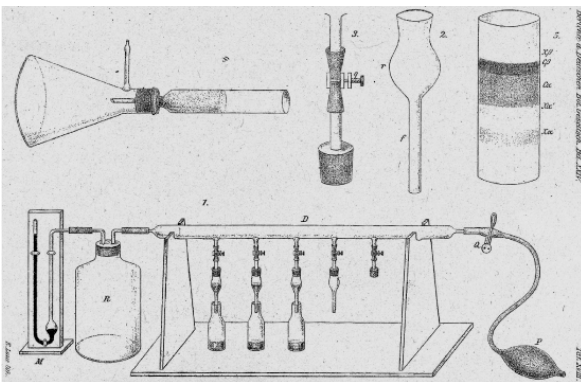
Figure 2. Tswett’s device with four packed chromatographic glass columns. Drawing (1.): three columns filled with adsorbents for the separation of plant pigments. The columns had an inner diameter of 2-3 mm, and a length of 2-3 cm. Drawing (5.): Separated zones of 5 colored plant pigments (Chlorophylls and Xanthophylls) in a chromatographic packed column. From ref. [9] with